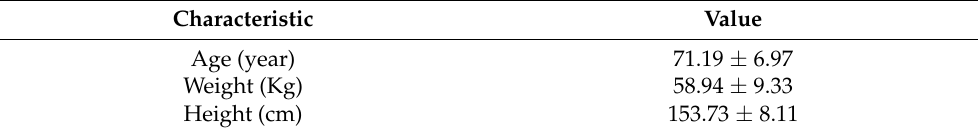
Table 1. Participant information.